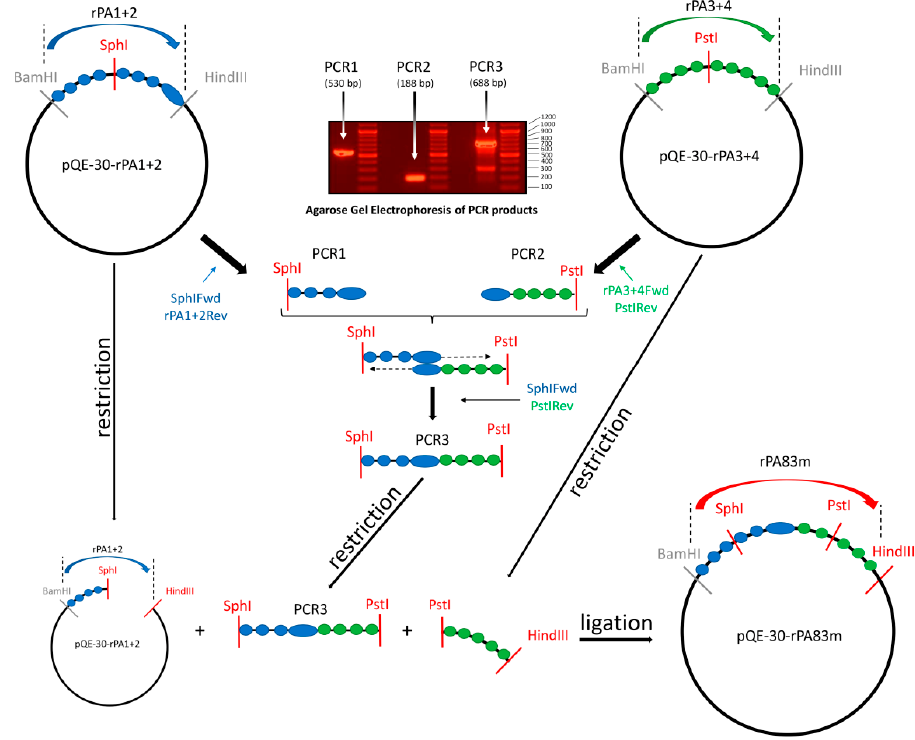
Figure 1. Graphical overview of the generation of the rPA83m expression vector. pQE-30-rPA1+2 and pQE-30-rPA3+4 are expression vectors containing nucleotide sequences of rPA1+2 and rPA3+4, respectively, that were cloned between the BamHI and HindIII cleavage sites. The rPA1+2-coding sequence is represented by blue rounds and the rPA3+4-coding sequence is represented by green rounds. The rPA1+2 3 ′ -end sequence included in the rPA3+4Fwd primer is represented by the oval. Primers are indicated with the colour of the matrix to which they are specific. SphI and PstI re- striction sites are located within the rPA1+2 and rPA3+4 nucleotide sequences, respectively. Re- striction sites used for one-step cloning are marked in red. PCR1 is a product corresponding to the 3 ′ -fragment of rPA1+2. PCR2 is a product corresponding to the 5 ′ -fragment of rPA3+4 and also contains a 20-nucleotide length sequence that is specific to the 3 ′ -end of rPA1+2. PCR3 is a fusion product generated by overlap PCR using PCR1 and PCR2 as primary fragments and SphIFwd and PstRev as flanking primers. 1% agarose gel electrophoresis (ethidium bromide staining) of purified PCR1 and PCR2, as well as a PCR mix containing amplified PCR3, is presented; the lengths of DNA ladder (GeneRuler DNA Ladder Mix, Thermo Scientific, Waltham, MA, USA) are indicated on the right.